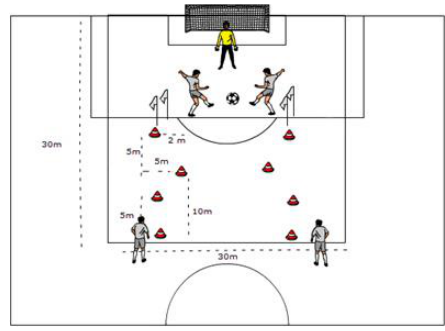
Figure 1. Circuit Training (i.e., 30 × 30 m 2 , individual occupied area per player = 90 m 2 ).